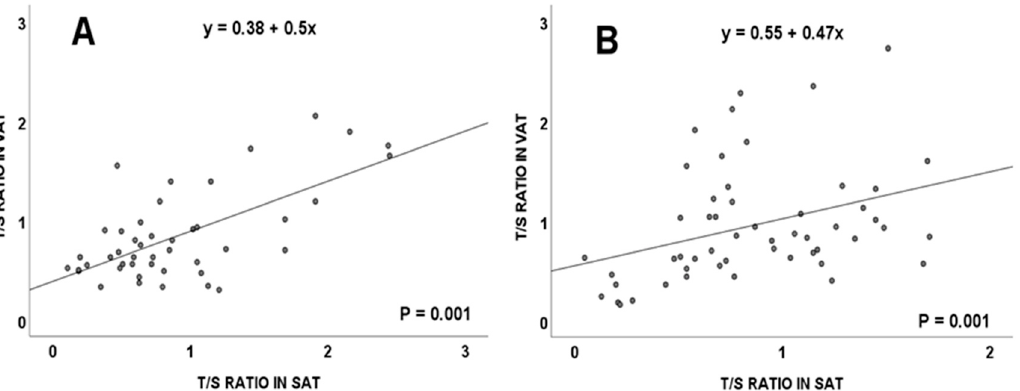
Figure 2. Telomere length (measured as T/S ratio) correlation between visceral and subcutaneous adipose tissues in the total population, considering body mass index from: overweight ( A ) and obese ( B ) subjects. VAT: visceral adipose tissue; SAT: subcutaneous adipose tissue.